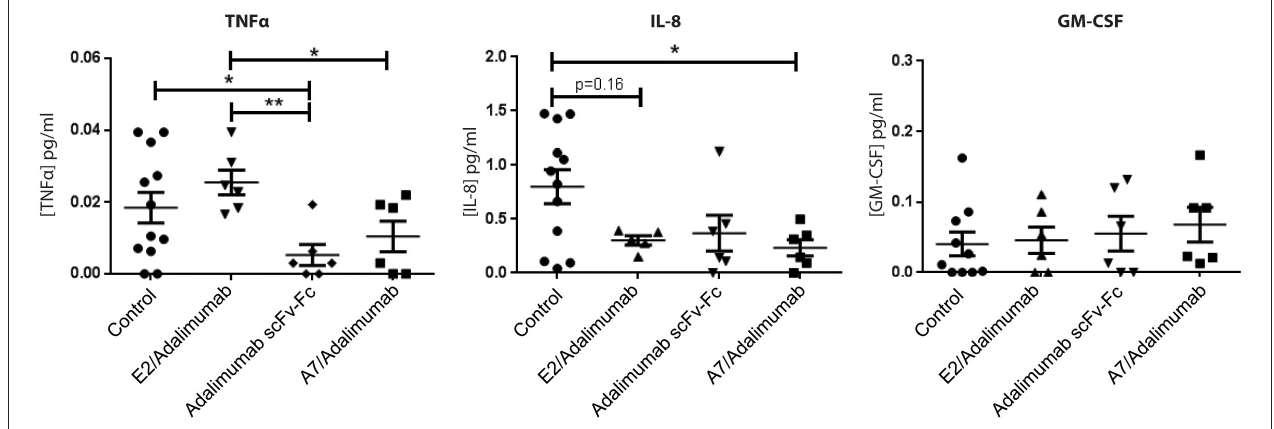
FIGURE 6 | Human cytokine concentrations in mouse sera. Selected human cytokine concentrations in sera collected at day 14 from mice receiving PBS and A7 scFv-Fc (control) ( n = 12), adalimumab scFv-Fc, A7/adalimumab, or E2/adalimumab ( n = 6) were measured using multiplex sandwich immunoassay. Values were expressed as mean ± SEM. Mann–Whitney non-parametric test (** p < 0.01, * p <